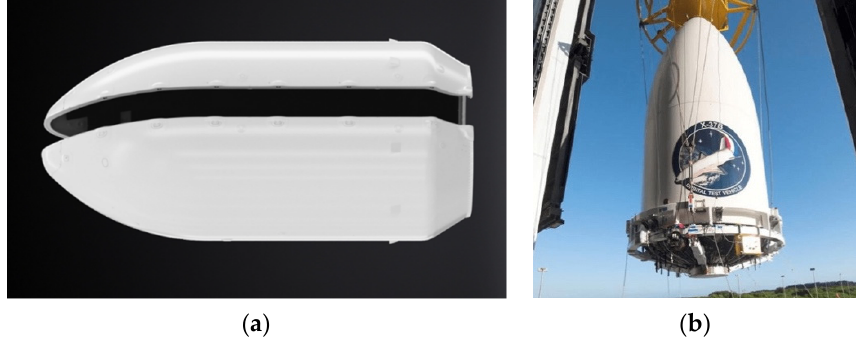
Figure 1. Schematic of a typical fairing. ( a ) Configuration I and ( b ) Configuration